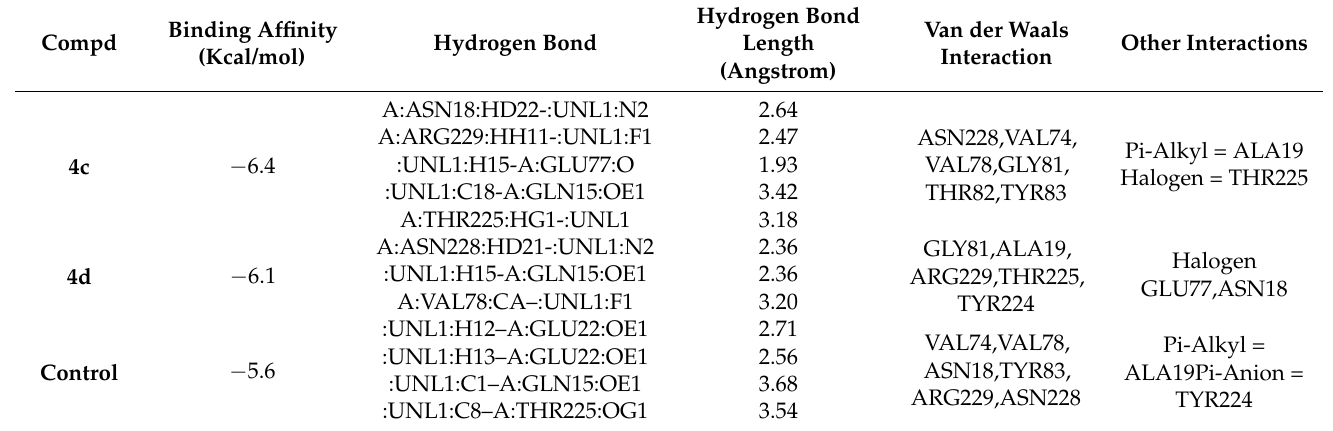
Table 4. Docking analysis of the covalent and non-covalent interactions of the derivatives ( 4c and 4d ) with the target protein, tubulin (6JCJ).